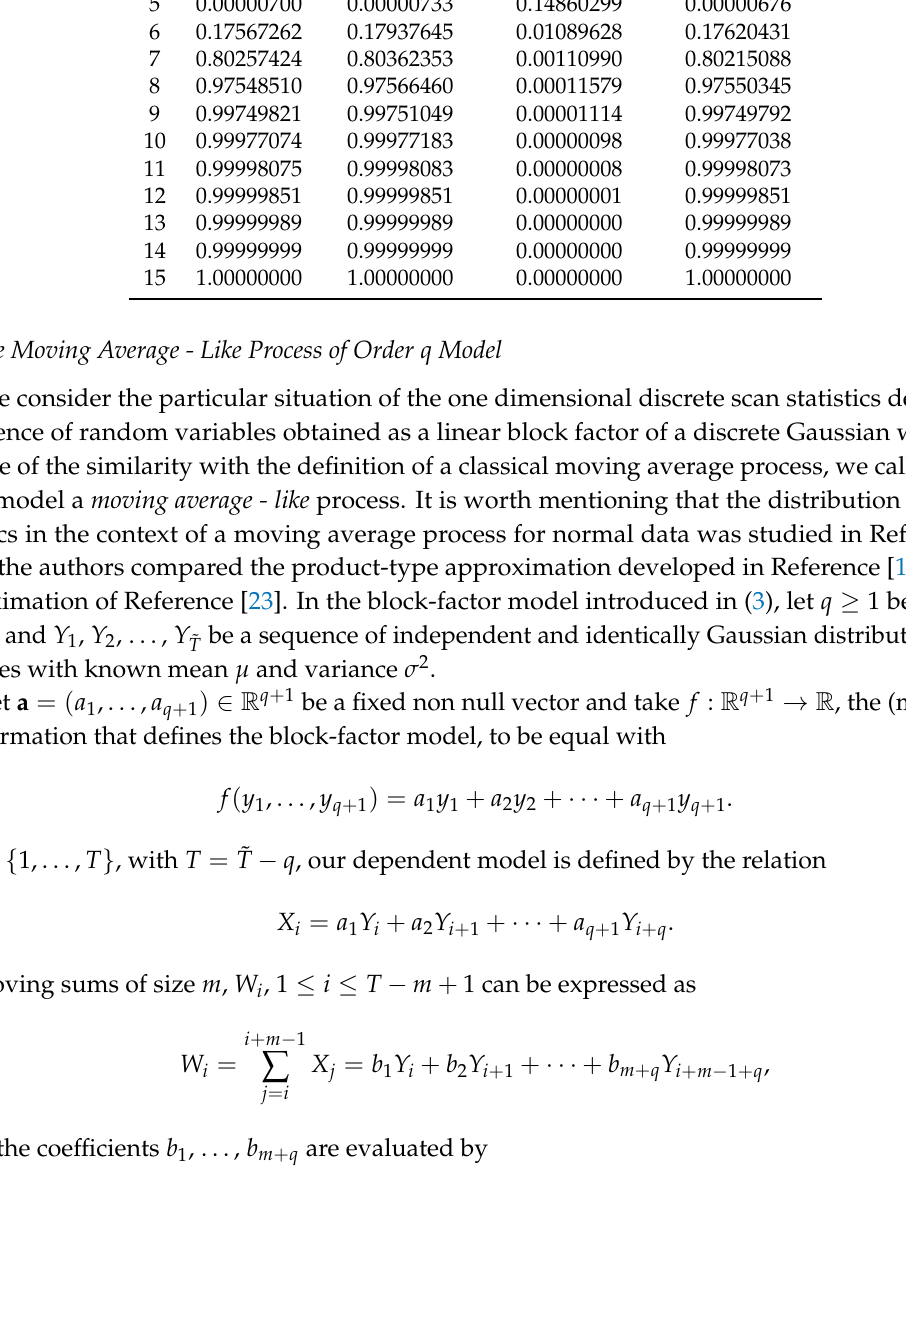
Table 2. The distribution of the length of the longest increasing run: ˜ T = 10001, ITER sim = 10 4 , ITER app = 10 5 . App E total m Sim